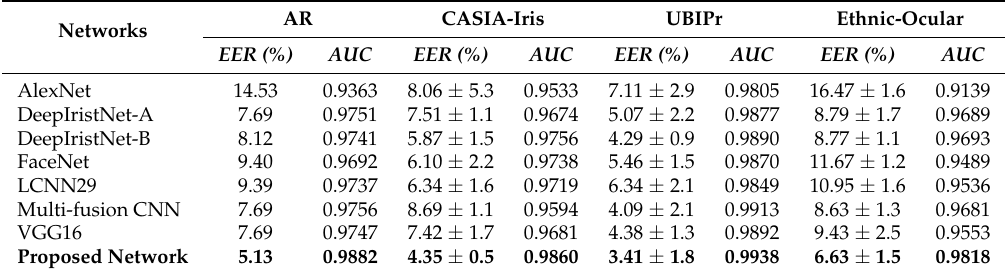
Figure 5. Performances of recognition and verification tasks on AR database. The figures are best viewed in colour. Table 4. Performance evaluation of the verification task on the AR database, CASIA-iris distance database, UBIPr database, and Ethnic-ocular database. The highest accuracy is written in